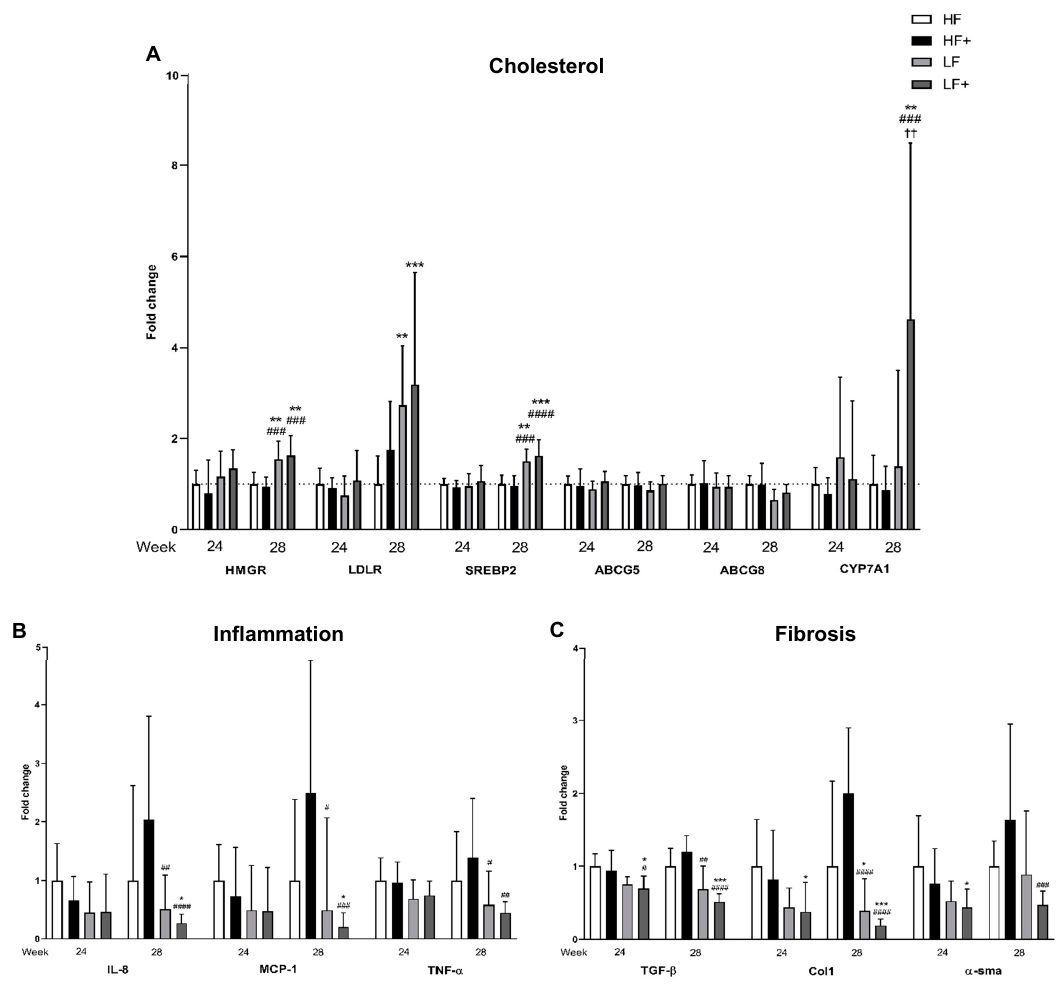
Figure 5. ( A ) Expression of HMGR and SREBP2 was increased in the LF and LF + group compared with HF and HF + , while an increase in LDLR expression was detected in the LF and LF + group compared to HF after 28 weeks. LF + had increased CYP7A1 expression compared to HF, HF + and LF at Week 28. No di ff erences were detected in the expression of bile acid transporters, ABCG5 and ABCG8, at any time point. ( B ) Compared to HF, a decrease in expression of IL-8 and MCP-1 was only detected in the LF + group. LF and LF + were both di ff erent in IL-8 and MCP-1 expression compared to HF + , after 28 weeks. At Week 28, TNF- α expression was reduced in the LF and LF + group compared to HF + , although a non-significant decrease, compared to HF, could also be observed. ( C ) After 24 weeks, LF + showed reduced expression in TGF- β compared to HF and HF + , with increased reduction after 28 weeks and LF was reduced compared to HF + after 28 weeks. LF and LF + both showed reduction in Col1a1 expression after 28 weeks, with increased significance in the LF + group. LF + also showed reduction in Col1a1 after 24 weeks, compared to HF. α -sma expression in LF + was reduced after 24 weeks compared to HF and after 28 weeks compared to HF + . Data are presented as means with ranges expressed as fold-changes relative to HF. * p < 0.05, ** p < 0.01, *** p < 0.001, compared to HF; # p < 0.05, ## p < 0.01, ### p < 0.001, #### p < 0.0001; compared to HF + . †† p < 0.01 compared to LF; n = 6–8 ( n = 6 for HF for all genes due to practical measures and to avoid plate to plate variation in the qPCR assay). HMGR, 3-hydroxy-3-methylglutaryl-coenzyme A reductase; LDLR, low-density lipoprotein receptor; SREBP2, sterol regulatory element binding protein 2; ABCG5 and -8, ATP-binding cassette sub-family G member 5 / 8; CYP7A1, cytochrome P450 7A1; IL-8, interleukin-8; MCP-1, monocyte chemotactic protein 1; TNF- α , tumor necrosis factor α ; TGF- β , transforming growth factor β ; Col1a1, collagen 1; α -sma, α smooth muscle